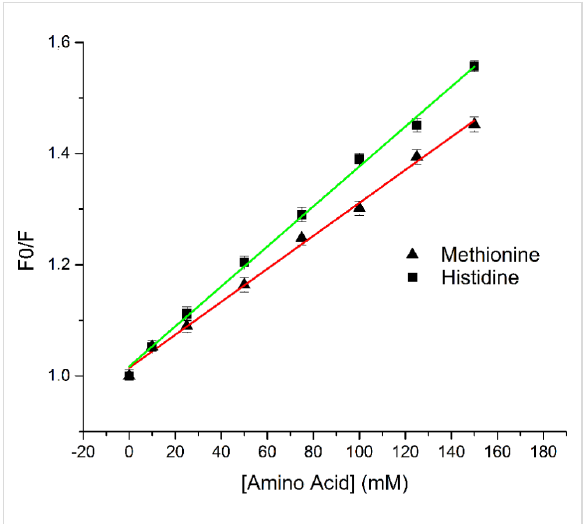
Figure 4: Comparison of quenching 2 µM NBDM, as measured by fluorescence intensity of methionine and histidine. Each data set was plotted in OriginPro 8.6 and fitted using a linear fit with direct